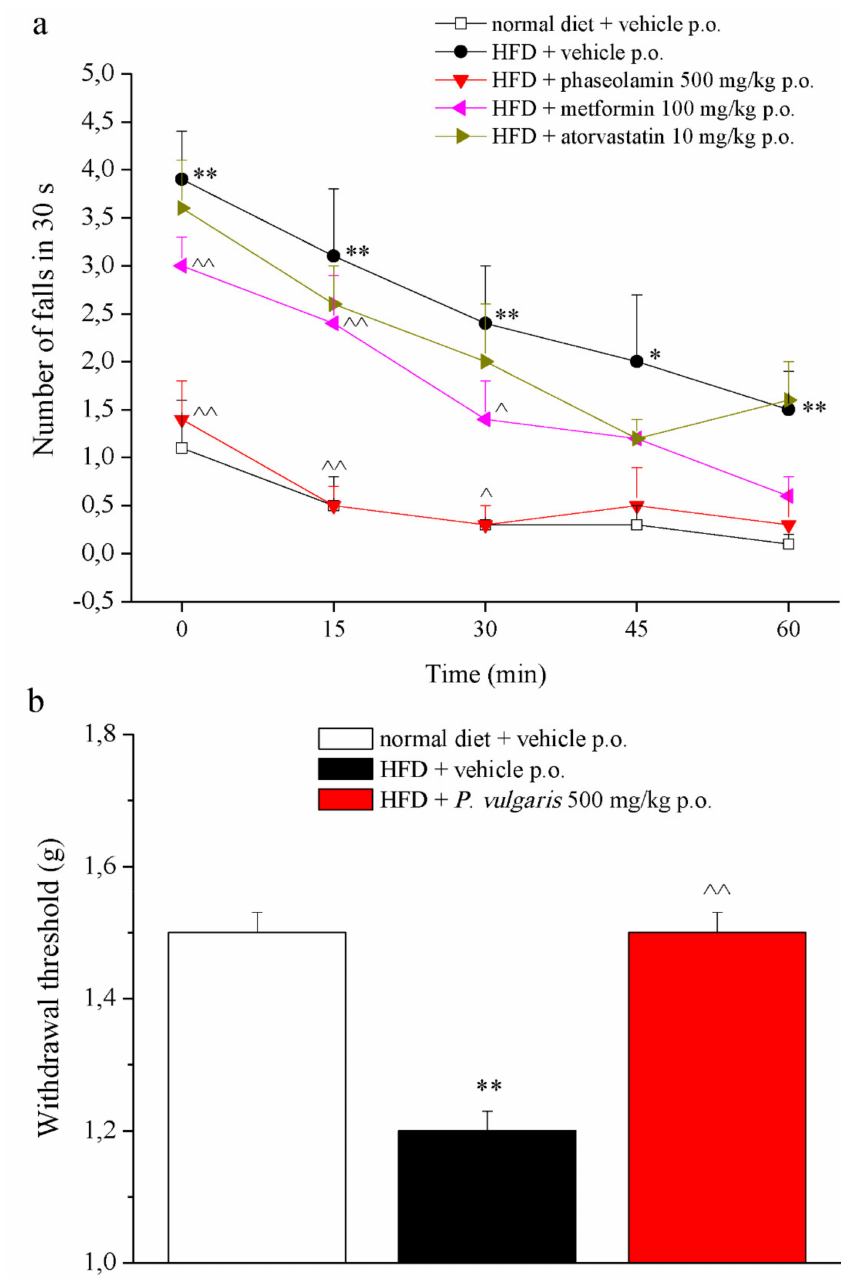
Figure 4. Behavior. ( a ) The integrity of the animals’ motor coordination (week 19) was assessed using a rota-rod apparatus. Rats were placed on a rotating rod (10 rpm) for 30 s every 15 min for 1 h. The number of falls was counted. ( b ) The pain threshold was measured by the Von Frey test to assess the response evoked by a mechanical non-noxious stimulus. Each value represents the mean ± S.E.M. of 12 mice per group. * p < 0.05 and ** p < 0.01 vs. normal diet + vehicle; ˆ p < 0.05 and ˆˆ p < 0.01 vs. HFD +